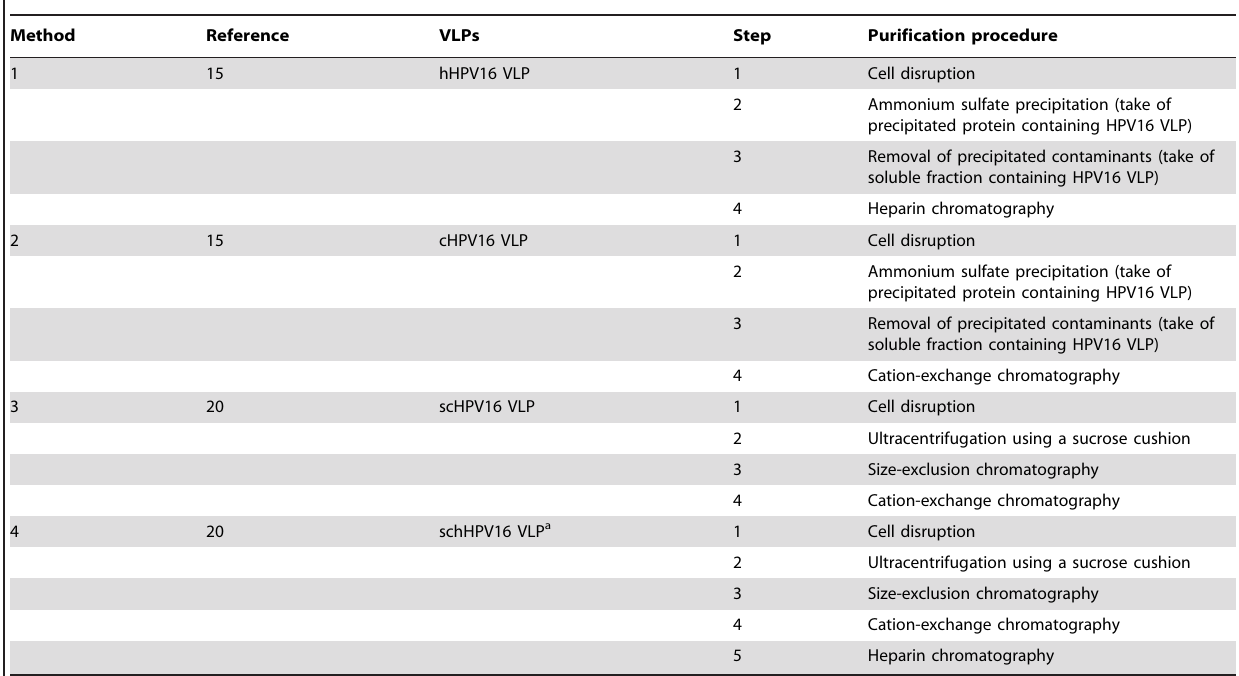
Table 1. Procedures used to purify the HPV16 VLPs used in this study.